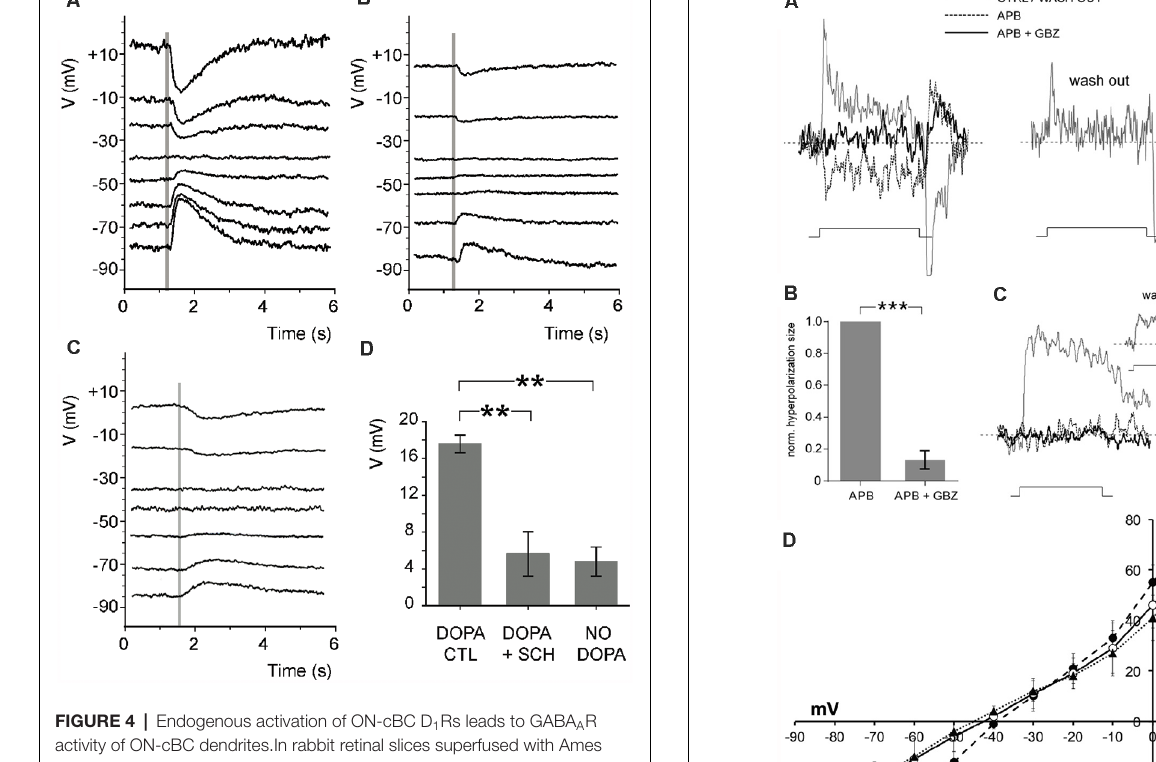
the transmitter GABA, and synaptic machinery to release GABA when the dendrites are depolarized has been difficult to